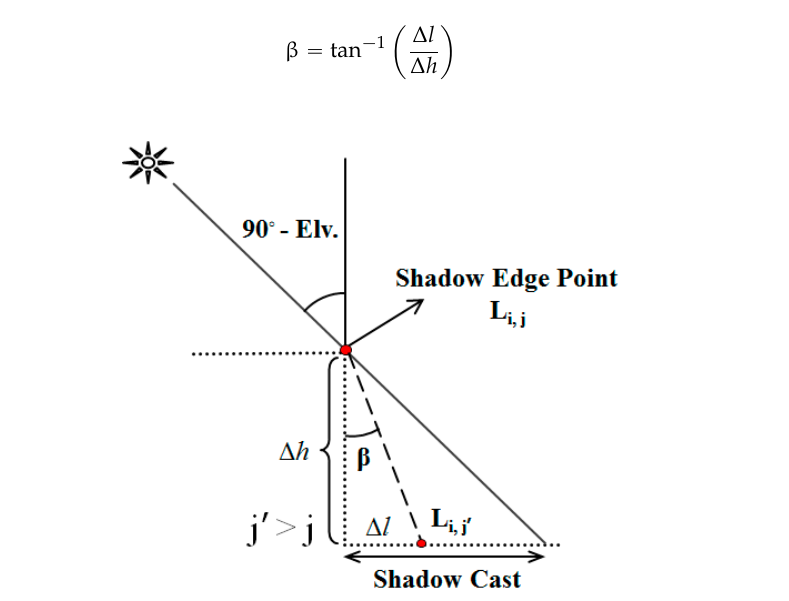
Figure 9. The concept applied for ray tracing process.